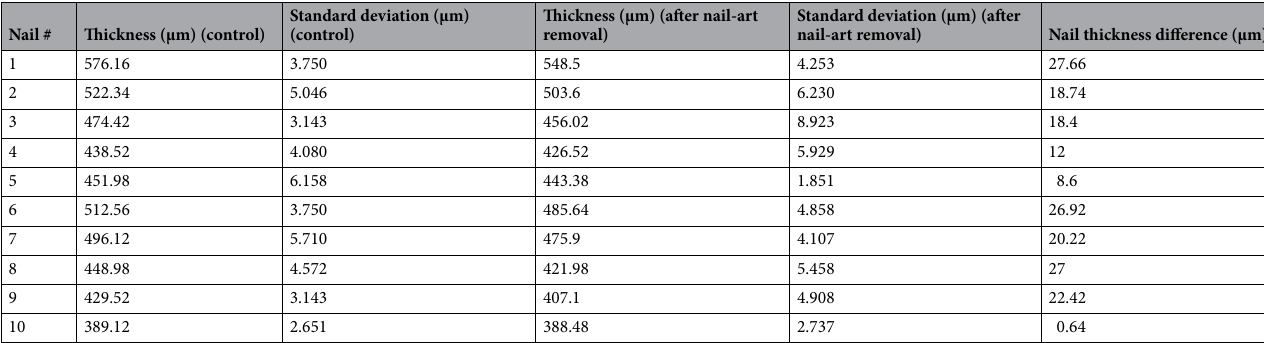
Table 1. Thickness difference of control and art-removed nails.